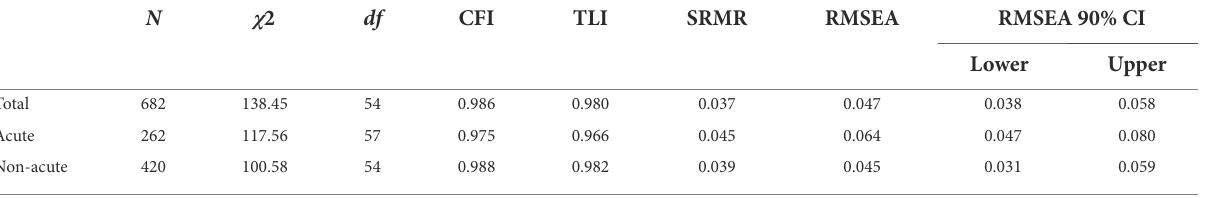
TABLE 3 Confirmatory factor analysis of the one-factor model of the ASADI-L.